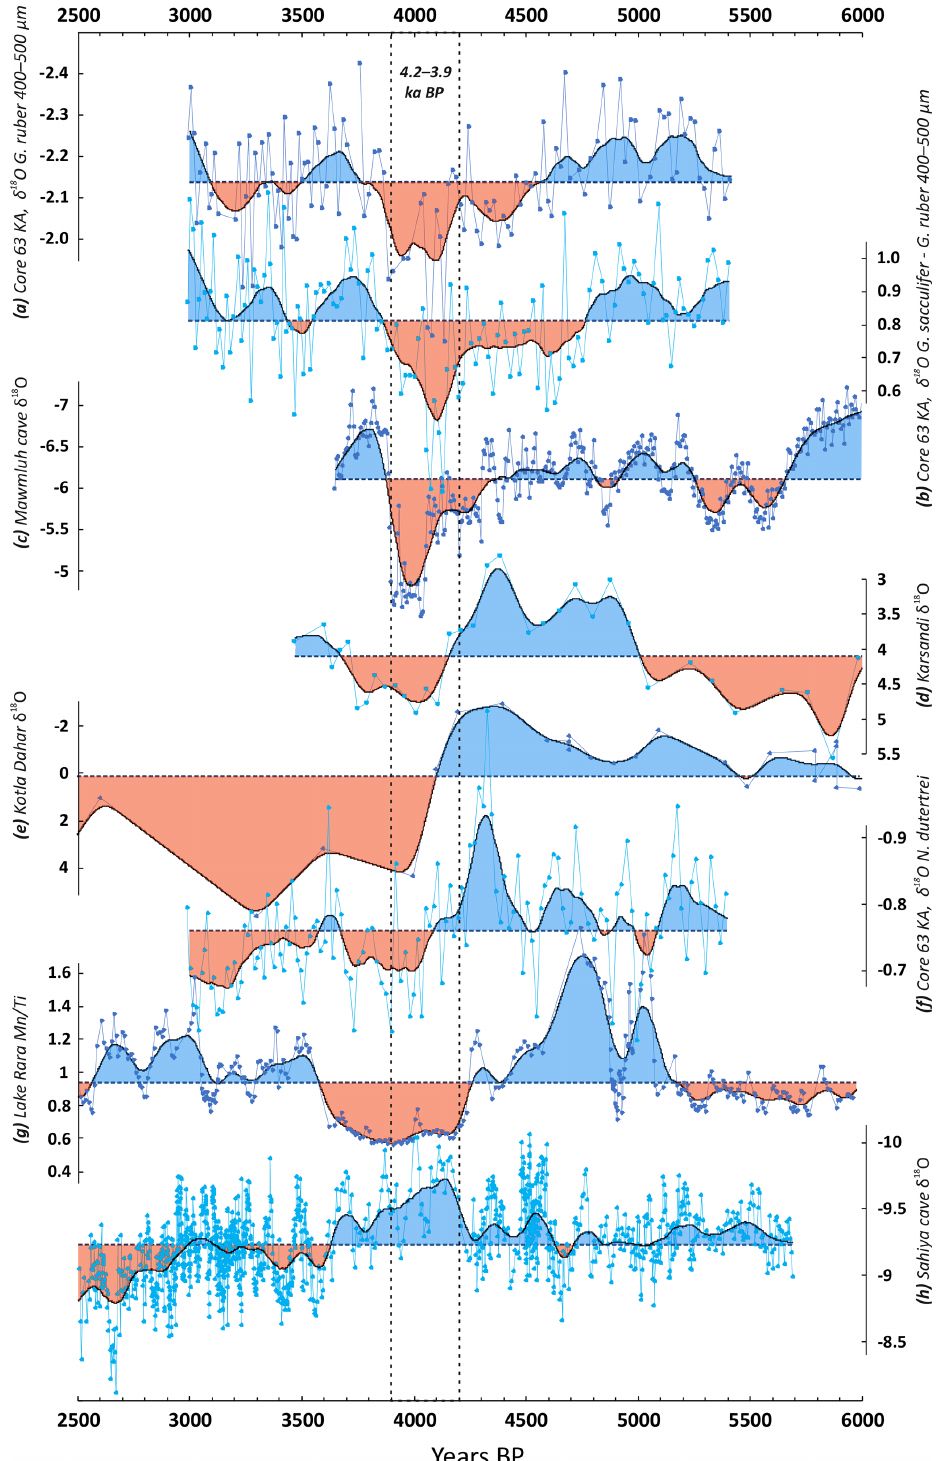
Figure 7. Comparison of the δ 18 O record of core 63KA with terrestrial records from the Indian subcontinent: (a, b) this study; (c) Berkel- hammer et al. (2012); (d) Dixit et al. (2018); (e) Dixit et al. (2014); (f) this study; (g) Nakamura et al. (2016); (h) Kathayat et al. (2017). The mean value for each record indicated by the horizontal dashed lines is taken for all available data between 6.0 and